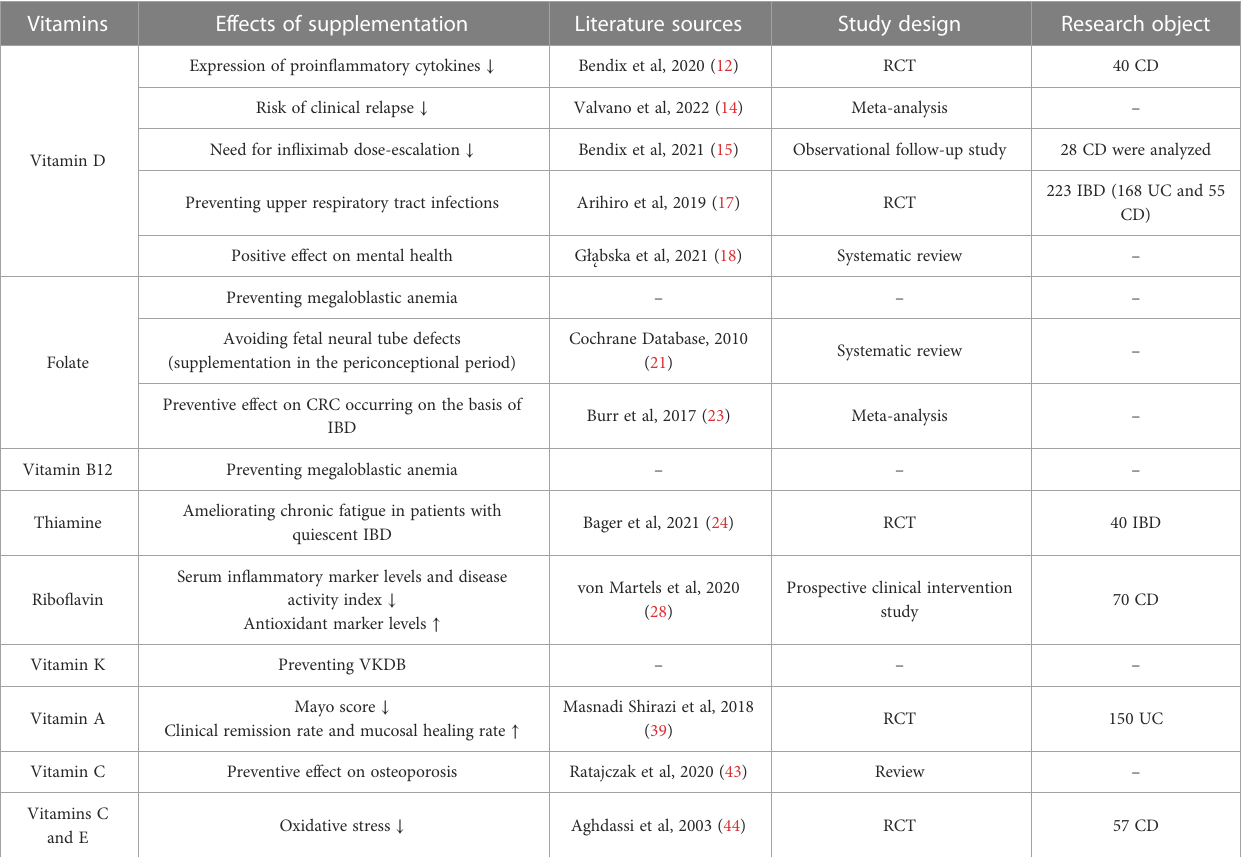
TABLE 1 Effects of vitamin supplementation in